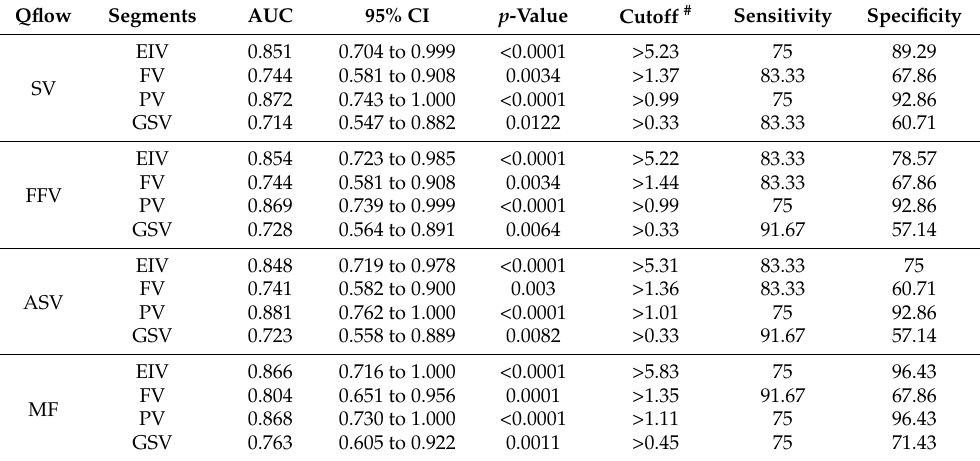
Table 4. The AUC analysis was performed to define the optimal cutoff values of SV, FFV, ASV, and MF because these QFlow parameters reached more significant differences between the reflux group and the HC group.